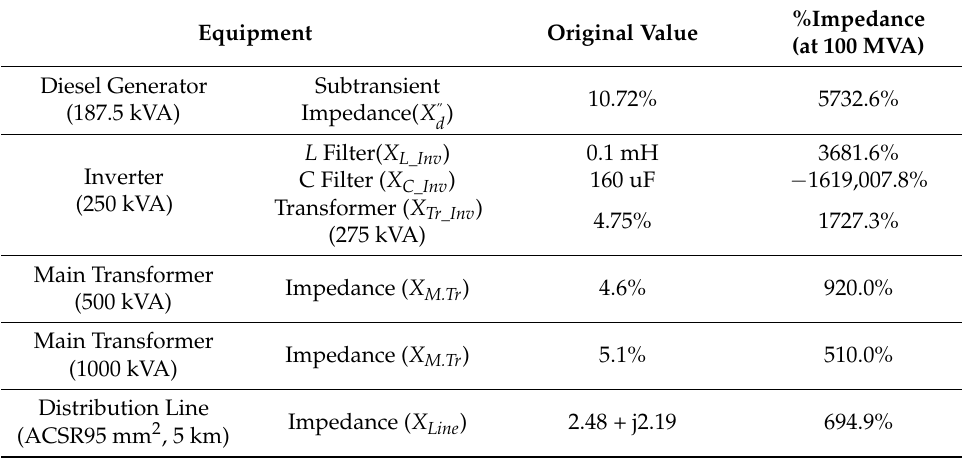
Table 3. % Impedance of generation sources and pieces of equipment